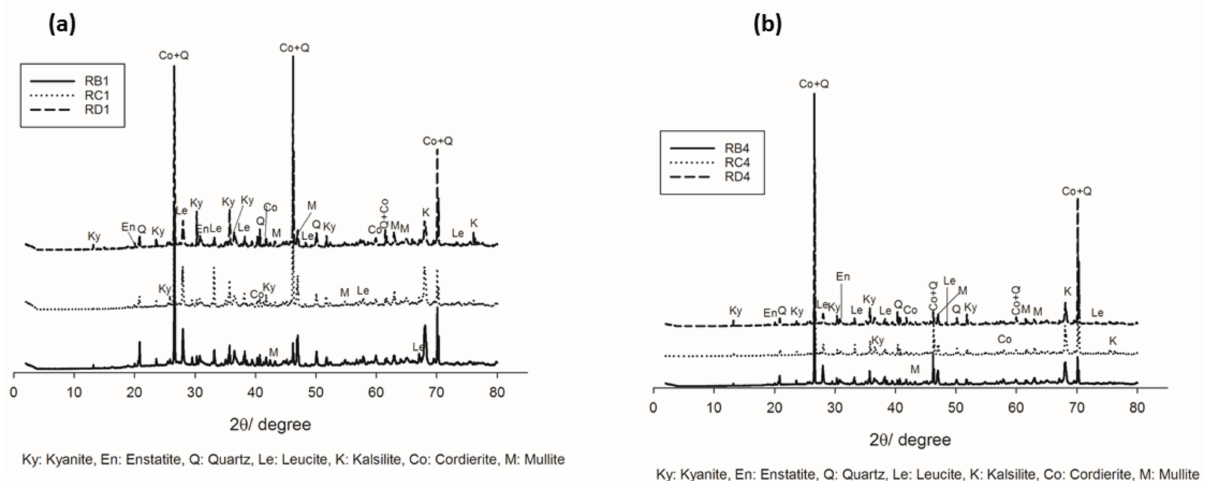
Figure 4. XRD patterns of the refractory geopolymer composites at 1200 ◦ C: ( a ) with 70 wt.% of kyanite added and ( b ) with 85 wt.%. of kyanite